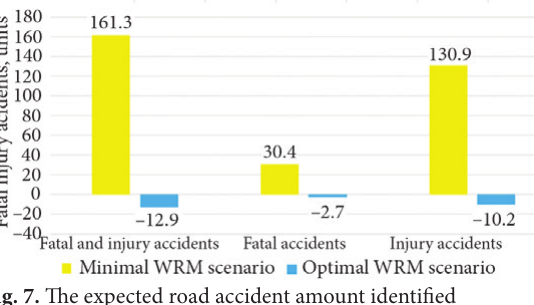
Fig. 7. The expected road accident amount identified by the model (the winter road maintenance scenarios applied in 2011–2014 winter seasons)